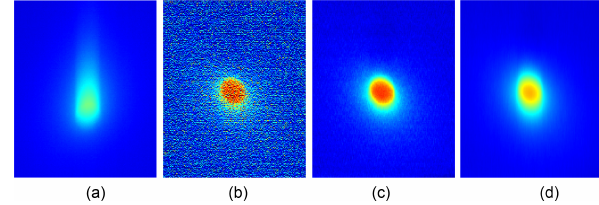
Figure 5. Infrared image of a hot ball, moving with 1ms − 1 (a) ; images restored with different k values: 0 (b) , 0.005 (c) and 0.05 (d) .